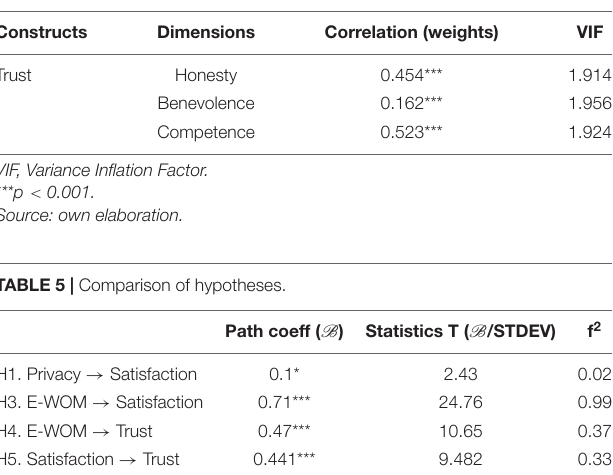
TABLE 4 | Measurement of the second-order model.